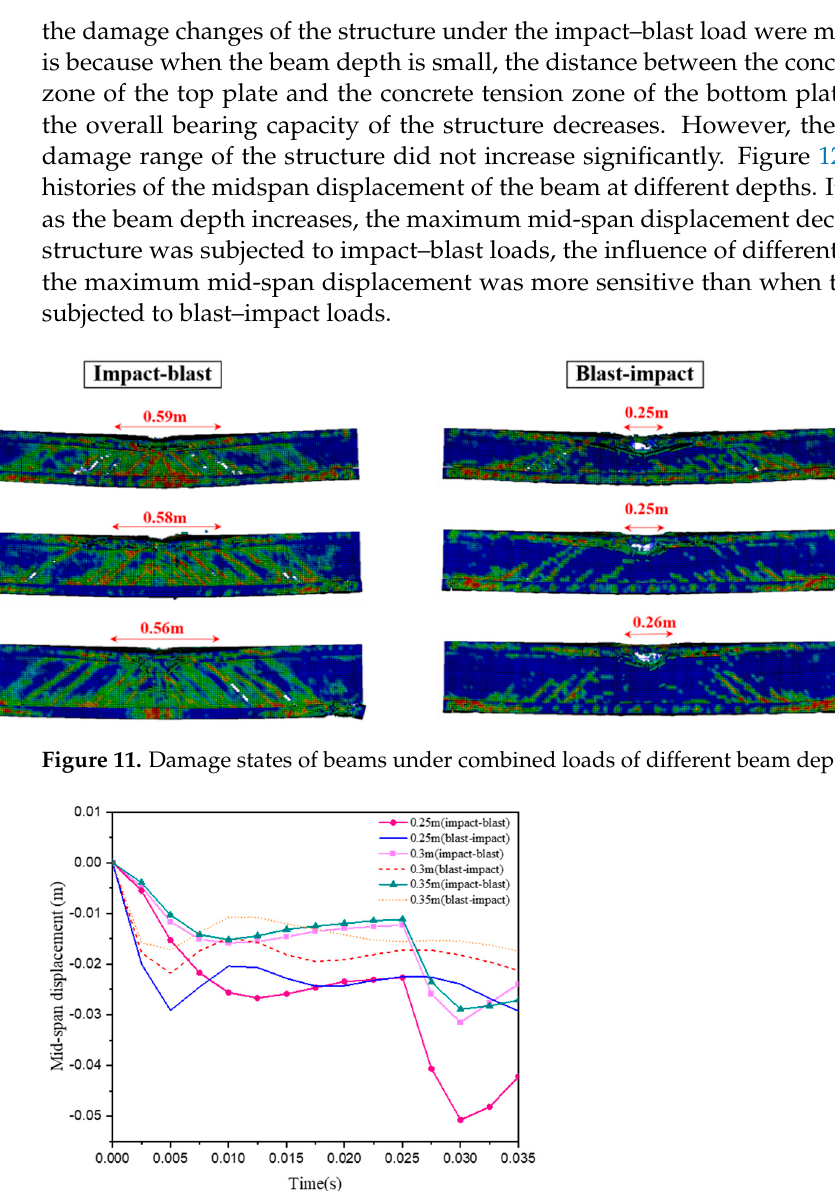
11 of 16 Figure 10. Time-history curves of mid-span displacement of beams under different beam spans. 4.3. Influences of Different Beam Depths Taking the beam depth as another structural parameter, the dynamic response and failure behavior of the structure under combined loads were studied under different beam